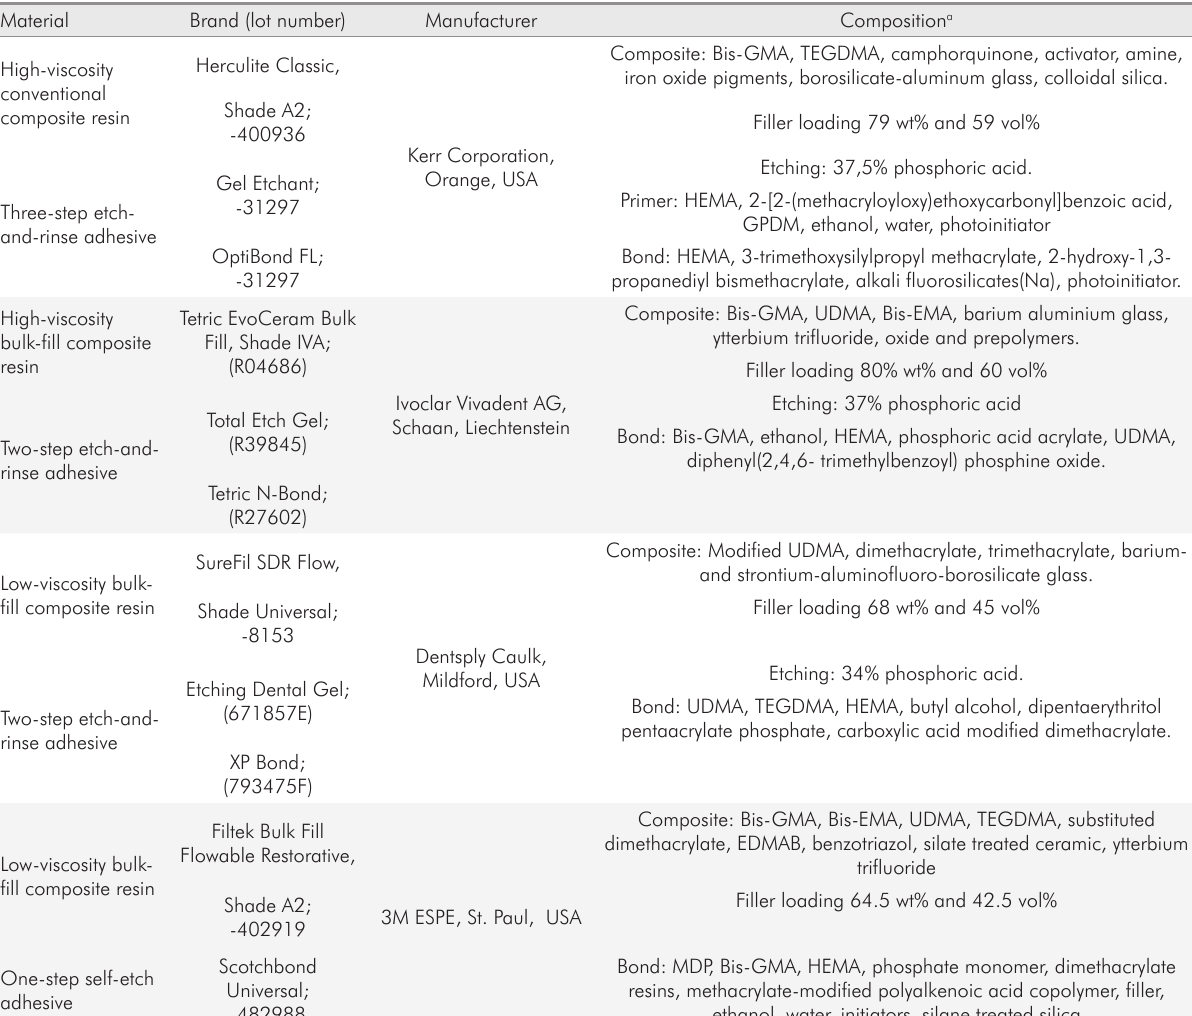
Table 1. Restorative systems used in this study and their respective manufacturer’s information.